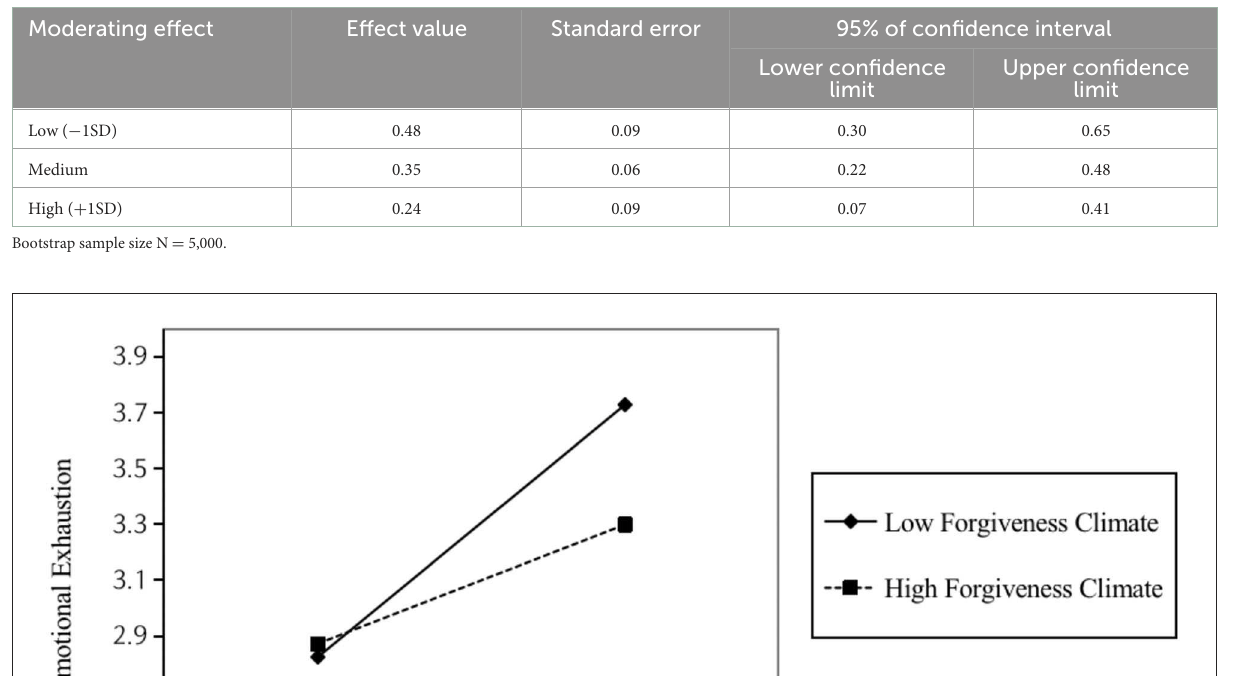
TABLE 5 The bootstrap test of the moderating effect with forgiveness climate.